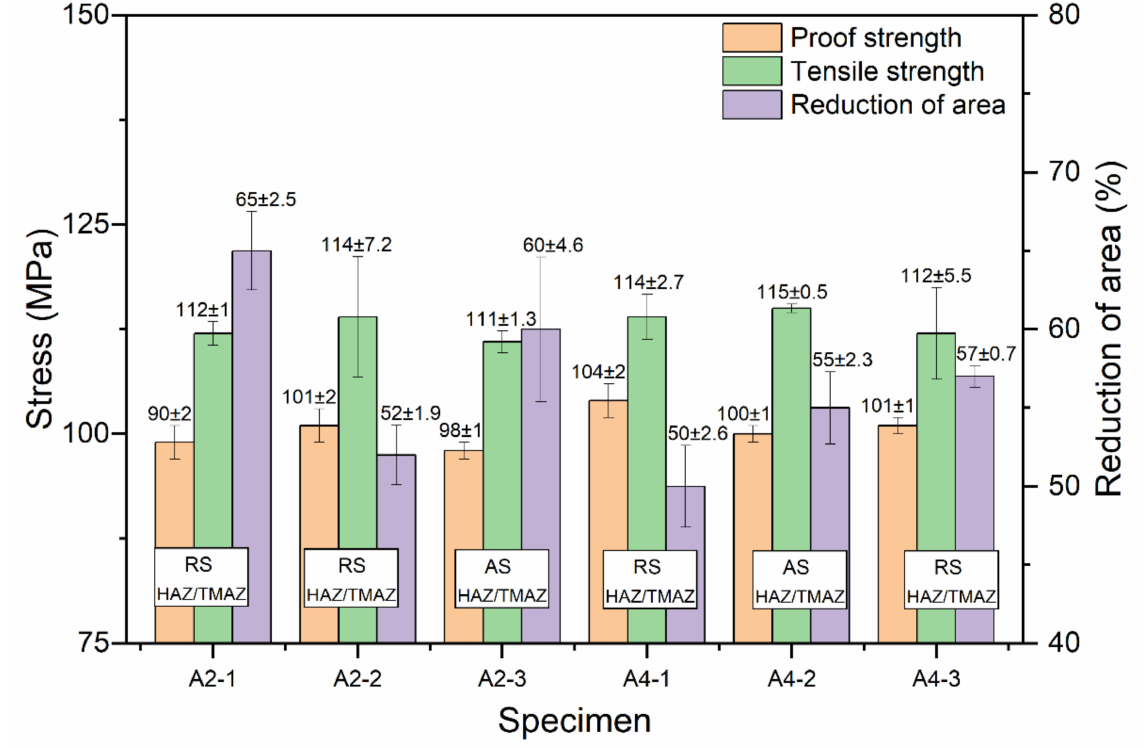
Figure 9. Results of tensile testing (AS—advancing side; RS—retrieving side; SZ—stir zone; HAZ— heat-affected zone; and TMAZ—thermomechanically affected